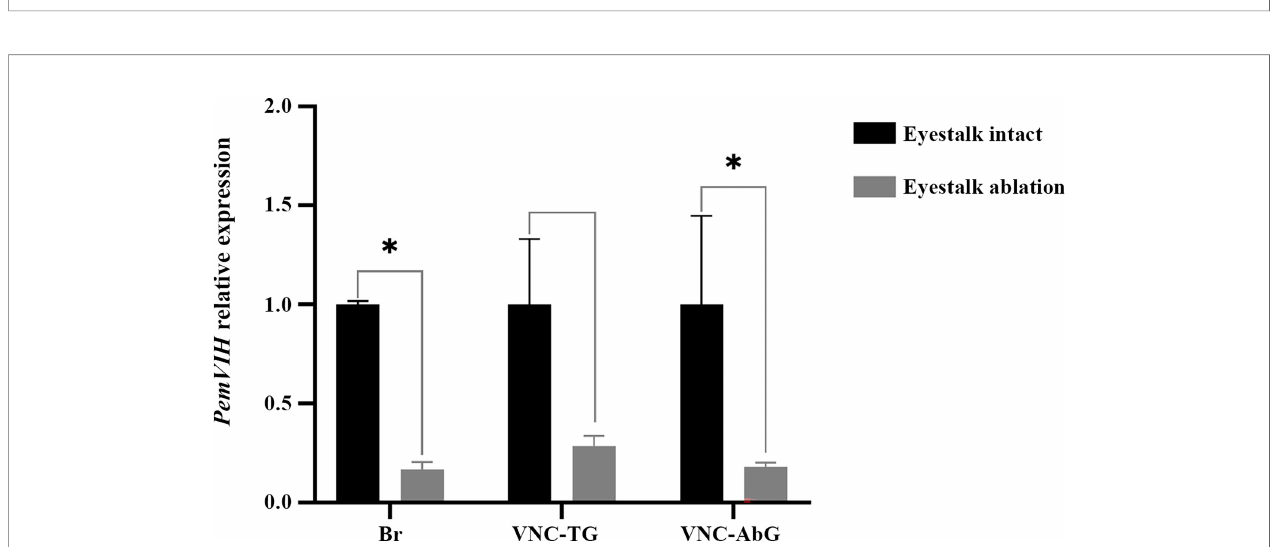
FIGURE 7 | Effect of eyestalk ablation on PemVIH expression. Relative expression of PemVIH ( PemVIH/actin ) was signi fi cantly decreased in Br and VNC-AbG of eyestalk-ablated females. Note that the VNC-TG included commissural ganglion (CoG), subesophageal ganglion (SEG), and thoracic ganglion (TG). Each bar = mean ± SEM (n = 3). Asterisks indicated statistic difference with *P < 0.05